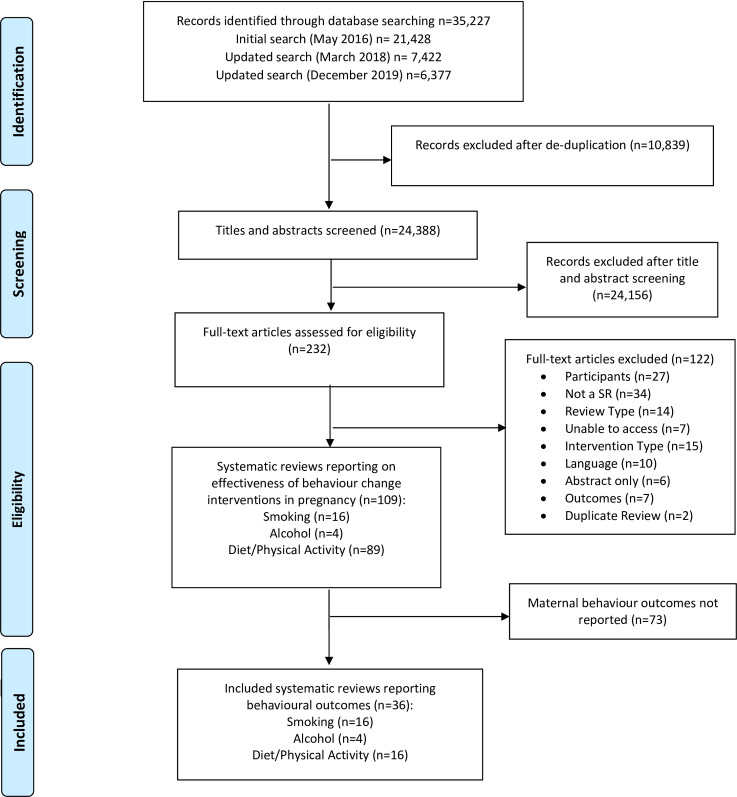
PRISMA flowchart.